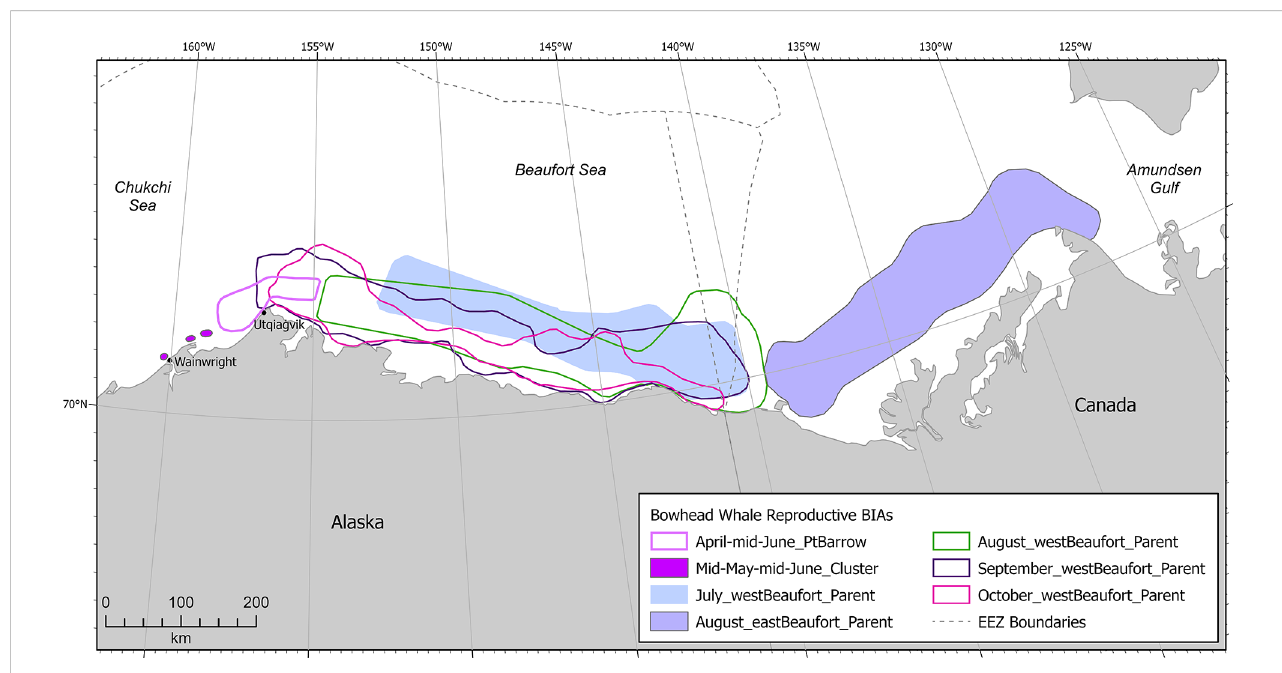
FIGURE 8 Arctic region bowhead whale reproductive BIAs (does not include child